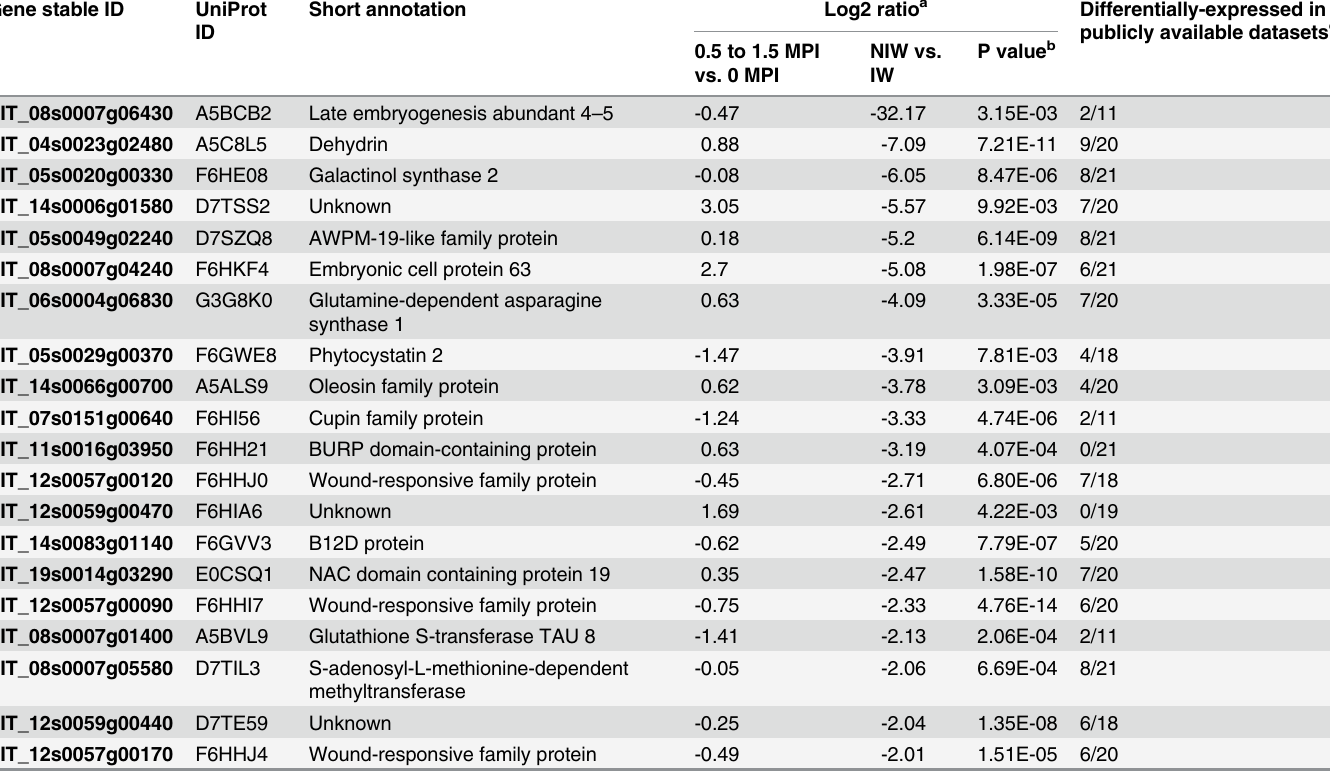
Table 3. Top 20 DEGs as a result of inoculation treatment and incubation